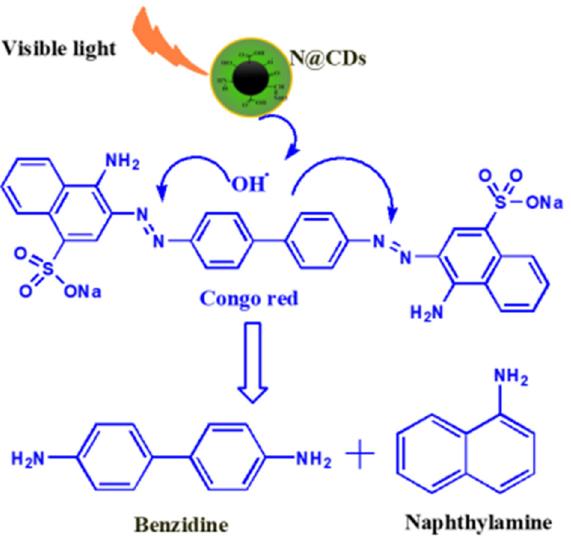
Scheme 1. Congo red is degraded to benzine and naphthylamine when the dye is subject to